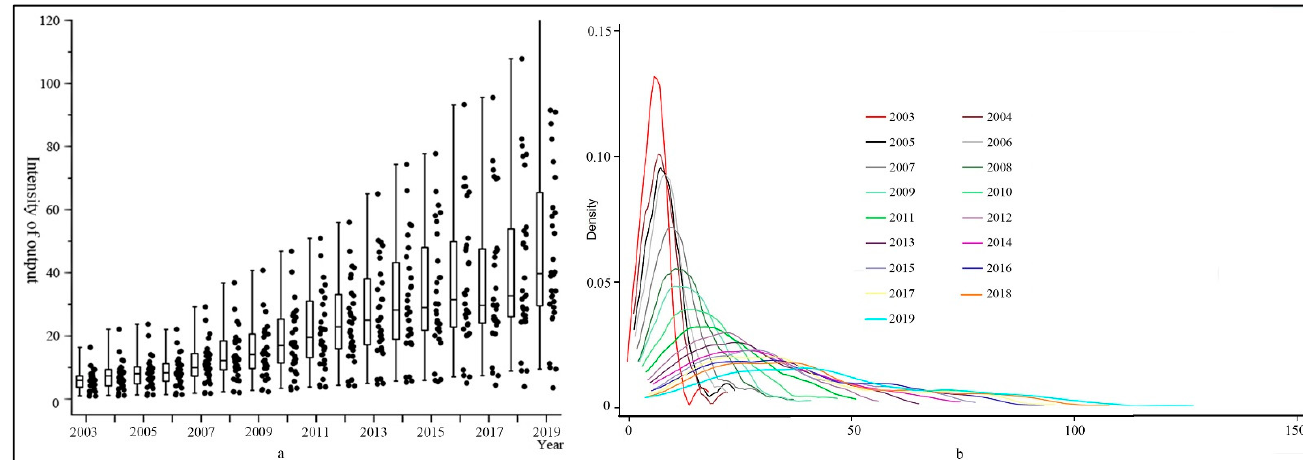
Figure 3. ( a ) Box-plot of agricultural water output intensity; ( b ) the Kernel density estimation of the agricultural water output intensity.